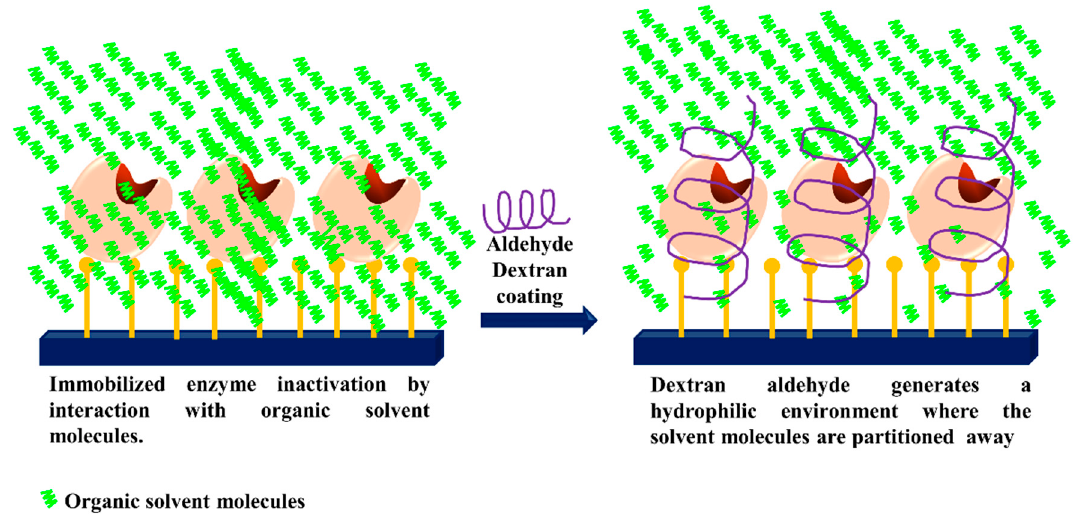
Figure 16. Generation of hydrophilic enzyme nanoenvironments by using dexOx.